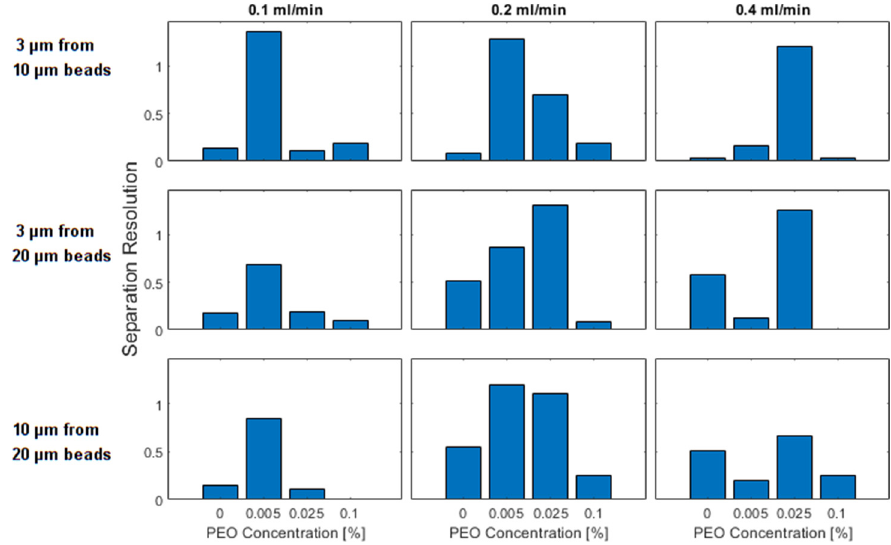
Figure 10. Separation resolution as a percentage of the channel width between the peaks formed in the focusing of differently sized particles. In the first row, 3 and 10 μ m beads are compared, in the second row 3 and 20 μ m beads are compared and in the third row 10 and 20 μ m beads are compared. The columns represent the flow rates of 0.1, 0.2, and 0.4 mL/min. The individual bars within a plot represent different PEO concentrations which increase from left to right.